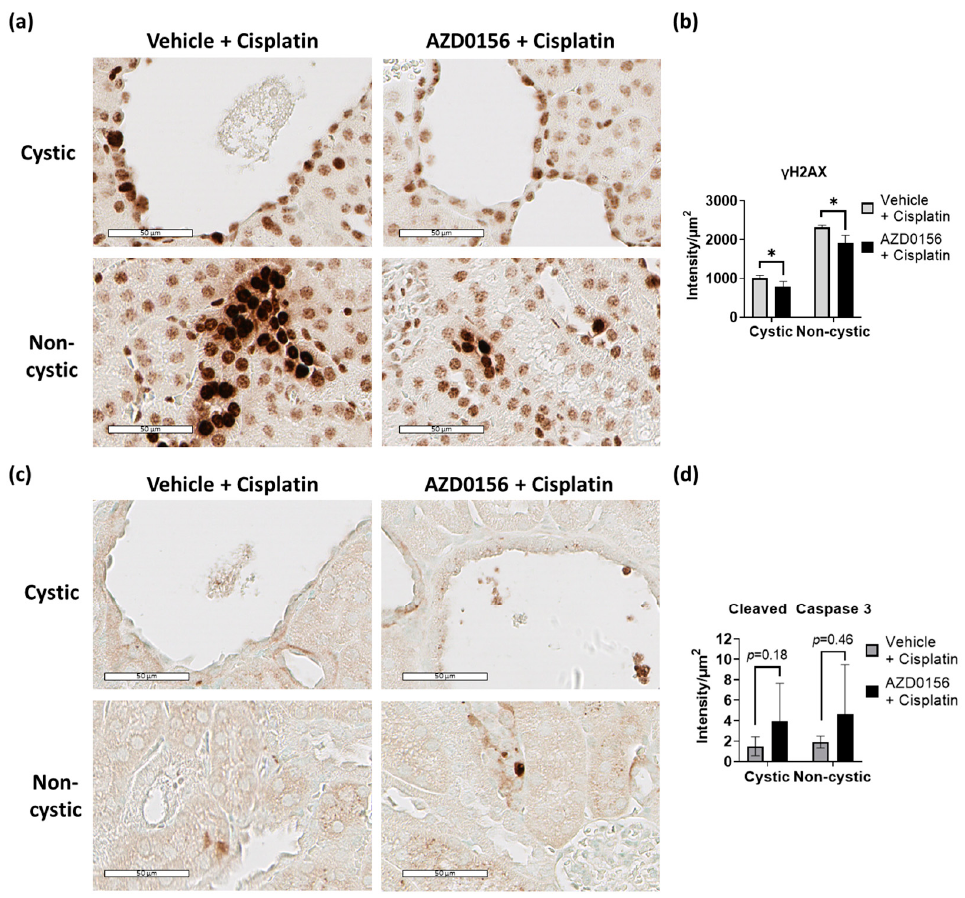
Figure 6. Pharmacological inhibition of ATM using AZD0156 in combination with low-dose cisplatin. ( a ) Immunohistochemical staining for γ H2AX and ( b ) quantification of intensity of strong positive γ H2AX pixels in cystic and non-cystic kidney tubules of mice treated with cisplatin combined with AZD0156 or vehicle ( n = 4–5 per group); ( c ) Immunohistochemical staining for cleaved caspase-3 and ( d ) quantification of intensity of strong positive pixels in cystic and non-cystic kidney tubules of mice treated with cisplatin combined with AZD0156 or vehicle ( n = 4–5 per group). Graphs showing mean with error bars representing standard deviation; * p < 0.05. Scale bars = 50 µm.